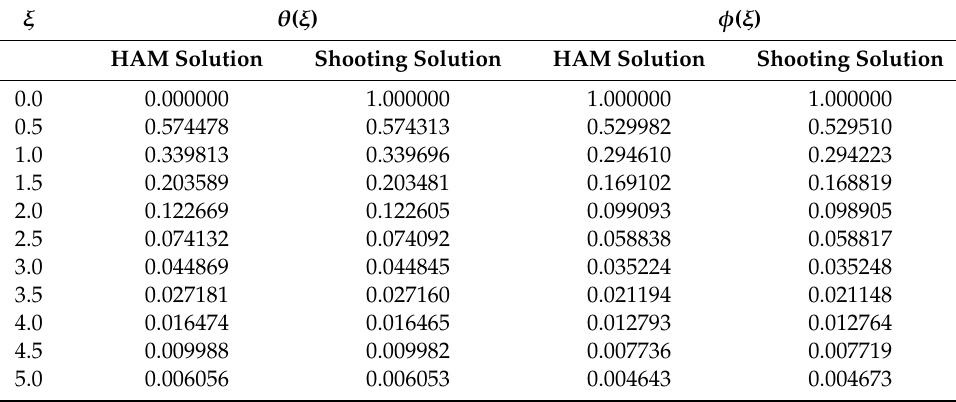
Table 5. Comparison of HAM and Shooting techniques for θ ( ξ ) and φ ( ξ ) considering other parameters